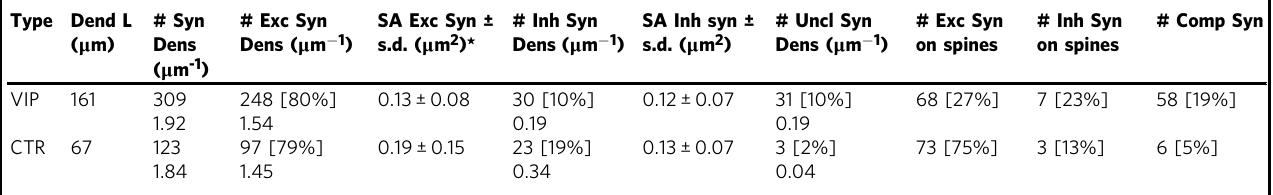
Table 2 Synapse